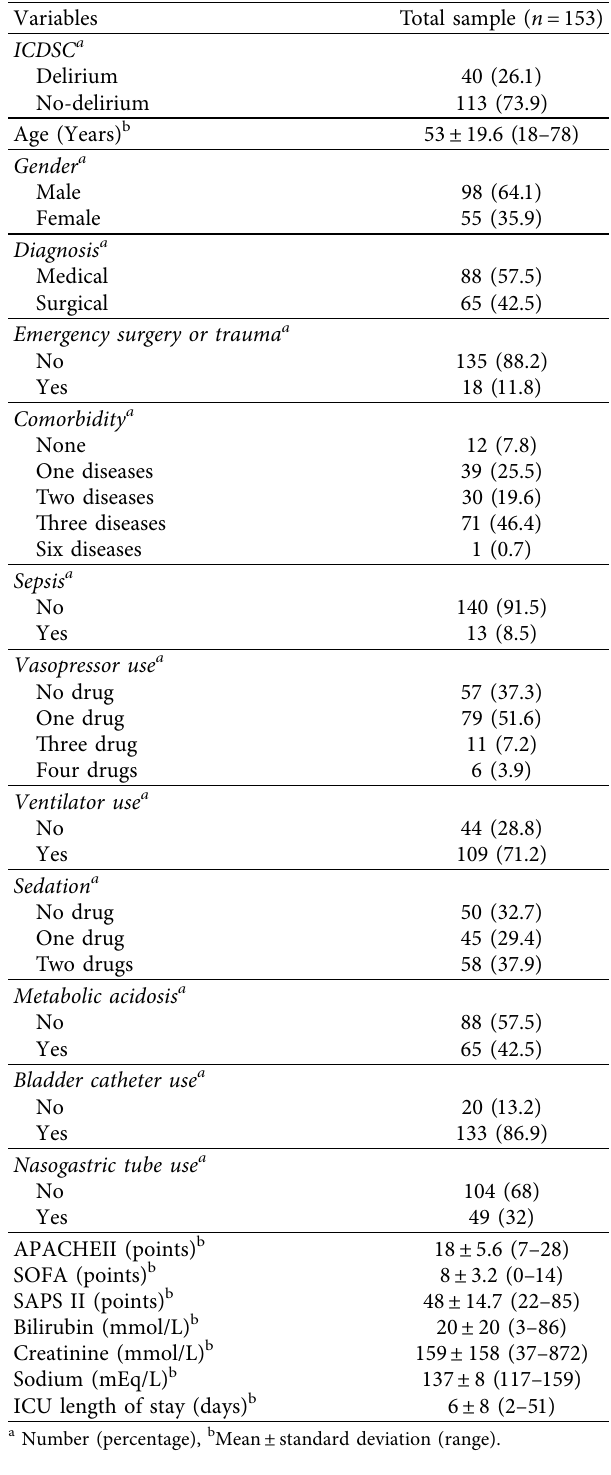
Table 1: Main clinical and demographic characteristics of the study participants( N �